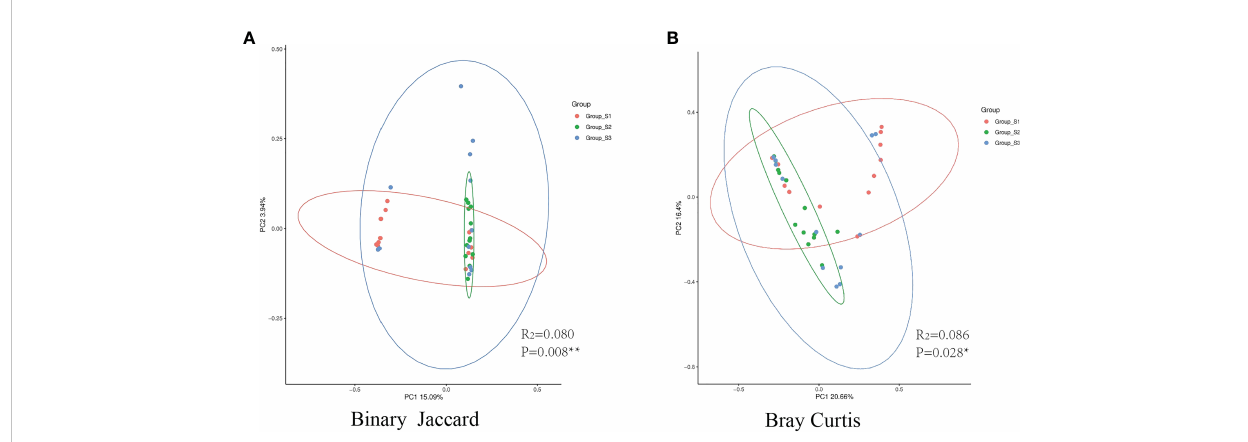
FIGURE 6 PCoA between different BMI groups. (A) The binary Jaccard algorithm was used to calculate the distance matrix of each group, and Adonis was used to analyze the difference between the presence or absence of species. (B) The Bray Curtis algorithm was used to analyze the difference in microbiota abundance. (The circle represents the 95% con fi dence interval of each group. Points farther away indicate greater differences by visualization). (*: P <0.05, there was a signi fi cant difference between the three groups in the distance matrix; **: P <0.01, there was a great signi fi cant difference between the three